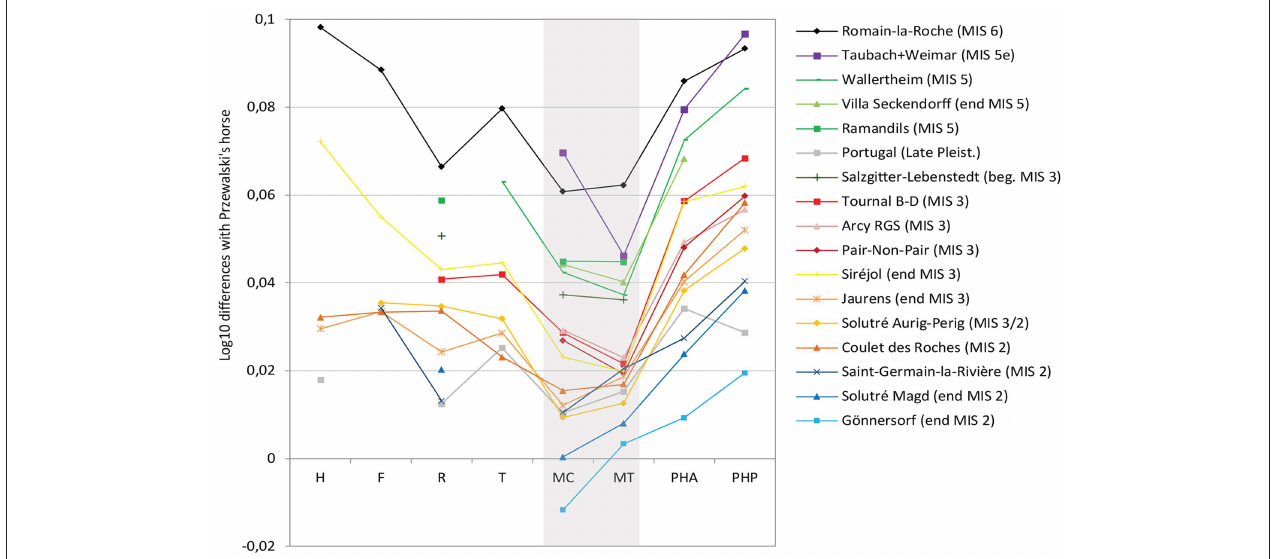
FIGURE 9 | Simpson’s ratio diagram of bone lengths of European Late Pleistocene true horses. Reference: Przewalski’s horse (Eisenmann, 1991a). H, Humerus; F, Femur; R, Radius; T, Tibia; MC, Metacarpal; MT, Metatarsal; PH1A, First Anterior Phalanx; PH1P, First Posterior Phalanx. Data: Romain-la-Roche (Boulbes, 2010); Taubach-Weimar (Eisenmann, pers. com.); Wallertheim, Villa Seckendorff, Gönnersdorf ( Cramer, 2002); Ramandils, Tournal B-D (Boulbes, pers. data); Siréjol ( Eisenmann, 2019); Jaurens (Eisenmann, 1991a); Solutré (Guadelli, 1991); Coulet-des-Roches (Crégut-Bonnoure et al., 2018); Saint-Germain-la-Rivière (Prat, 1968).